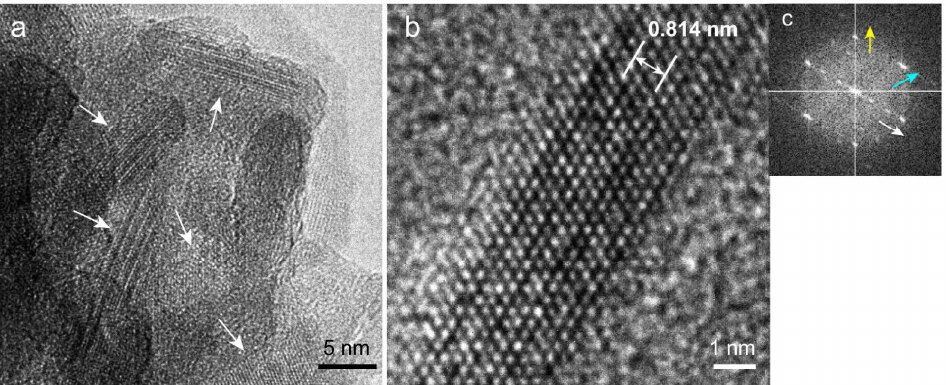
Figure 8 . Narrow-area TEM images of nanorods. ( a ) Aggregation of nanorods. The orientation of each rod was random, and lattice fringes were observed in the rods. ( b ) HR-TEM image of a rod. The lattice image of the rod is visible. ( c ) FFT image of a rod. Three directions of the crystal planes are indicated by white, blue, and yellow arrows. The interplanar distance corresponding to the direction of the white arrow (0.814 nm) is superimposed in ( b ).